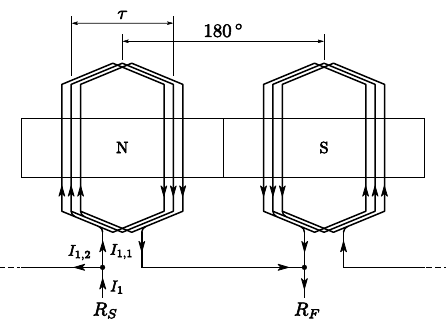
Figure 2. Unrolled view of phase 1 of a multifunction winding performing both motor and passive electrodynamic magnetic bearing (EDB) centering functions for a one-pole pair internal permanent magnet rotor.